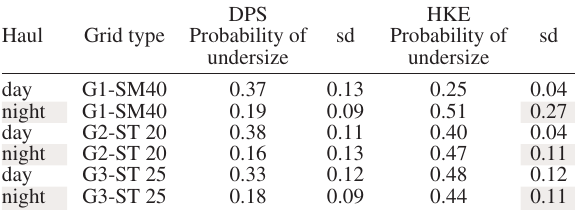
Table 3. – Probability of undersized specimens of deep-water rose shrimp (DPS) and European hake (HKE), recorded during the daily and nightly hauls with and without JTEDs. G1-SM40, JTED cov- ered with a net of 40-mm square mesh; G2-ST20, JTED with steel bars spaced 20 mm; G3-ST25, JTED with steel bars spaced 25